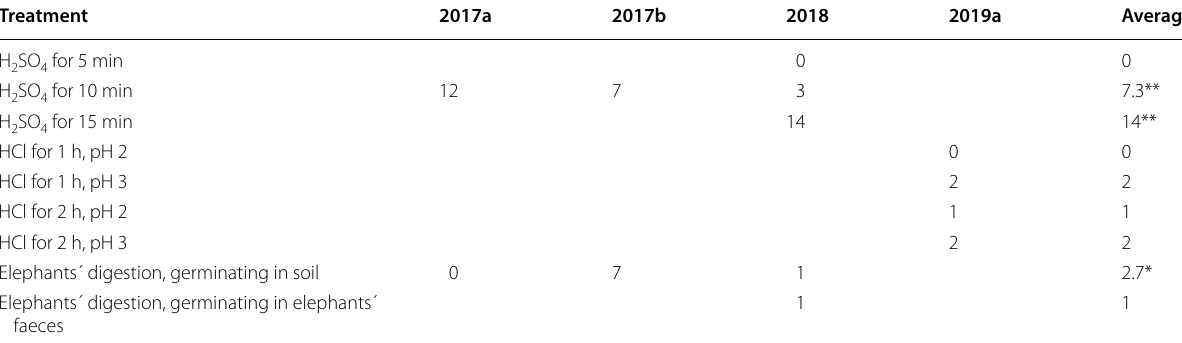
Table 2 Acid treatment: relative germination rate of Adansonia digitata seeds after 10 weeks [%]